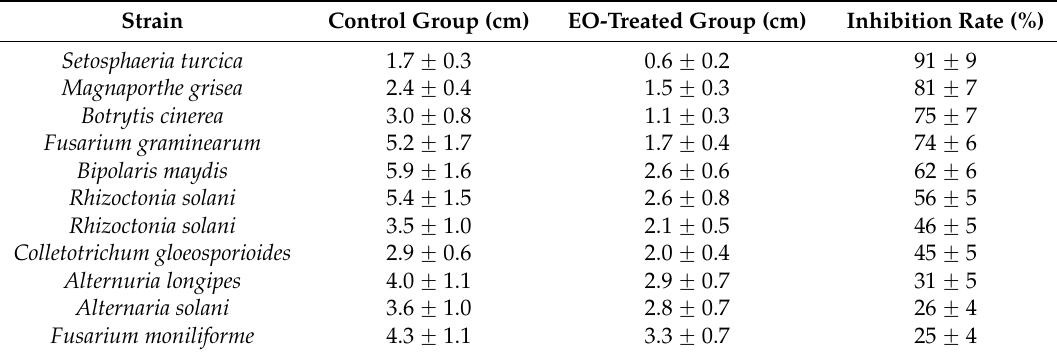
Table 1. Inhibitory activities of the Eucalyptus oil on plant pathogenic